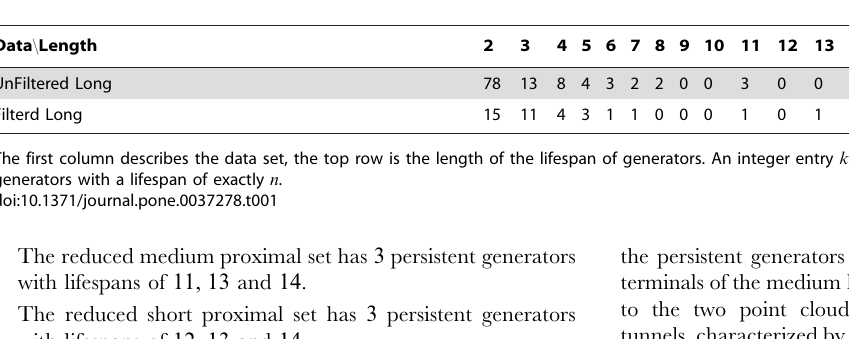
Table 1. Comparison of filtered and unfiltered data.